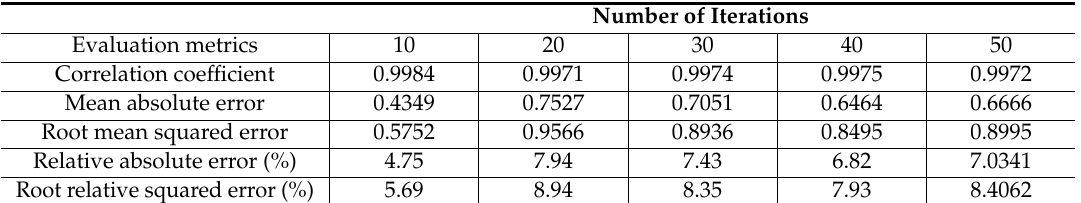
Table 2. Evaluation metrics calculated for the alternating model tree (AMT) method varied based on number of